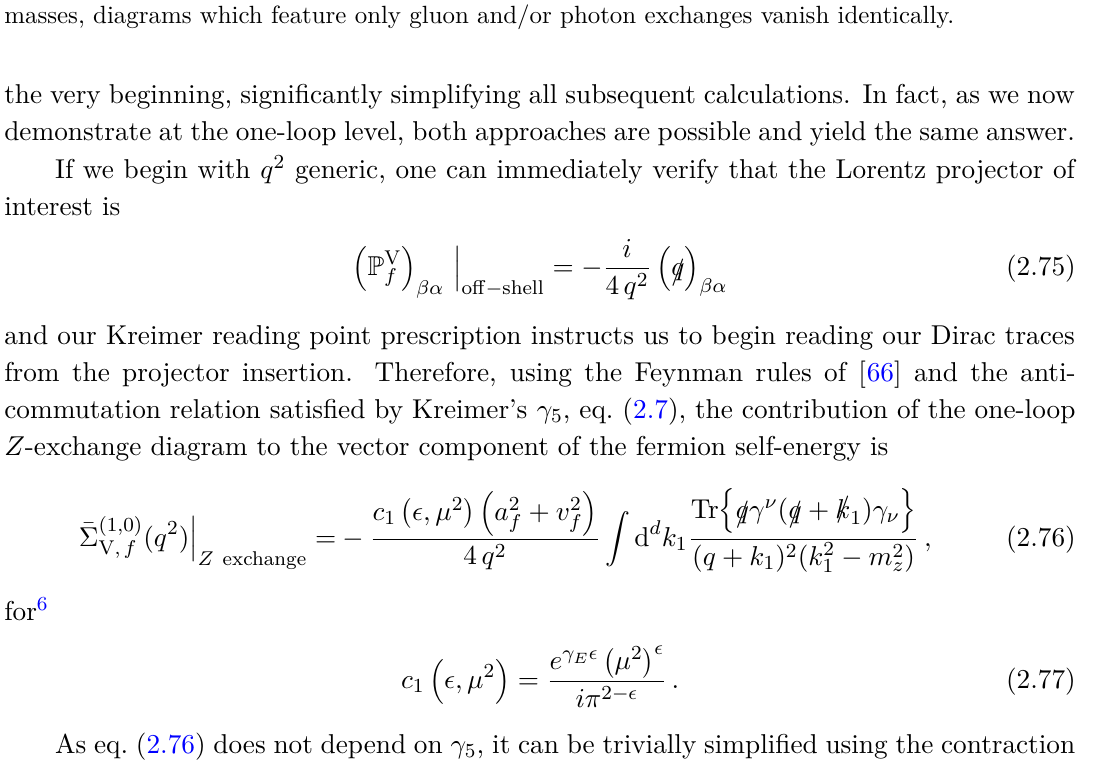
Figure 2 . Independent Z exchange diagrams at one and two loops. Due to the absence of fermion masses, diagrams which feature only gluon and/or photon exchanges vanish